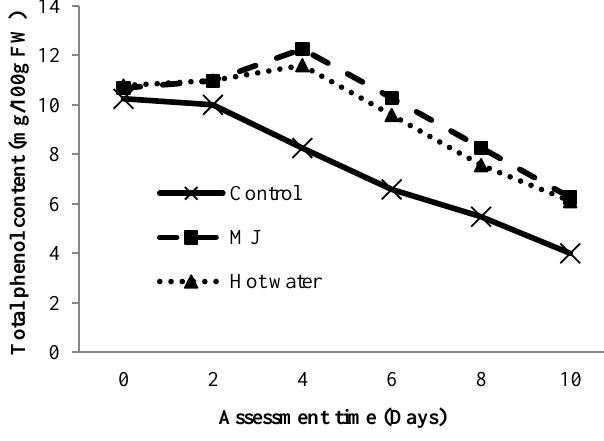
Figure 4. Effects of different postharvest treatments on total phenol content of apricot fruits during storage at room temperature (MJ: methyl jasmonic acid).